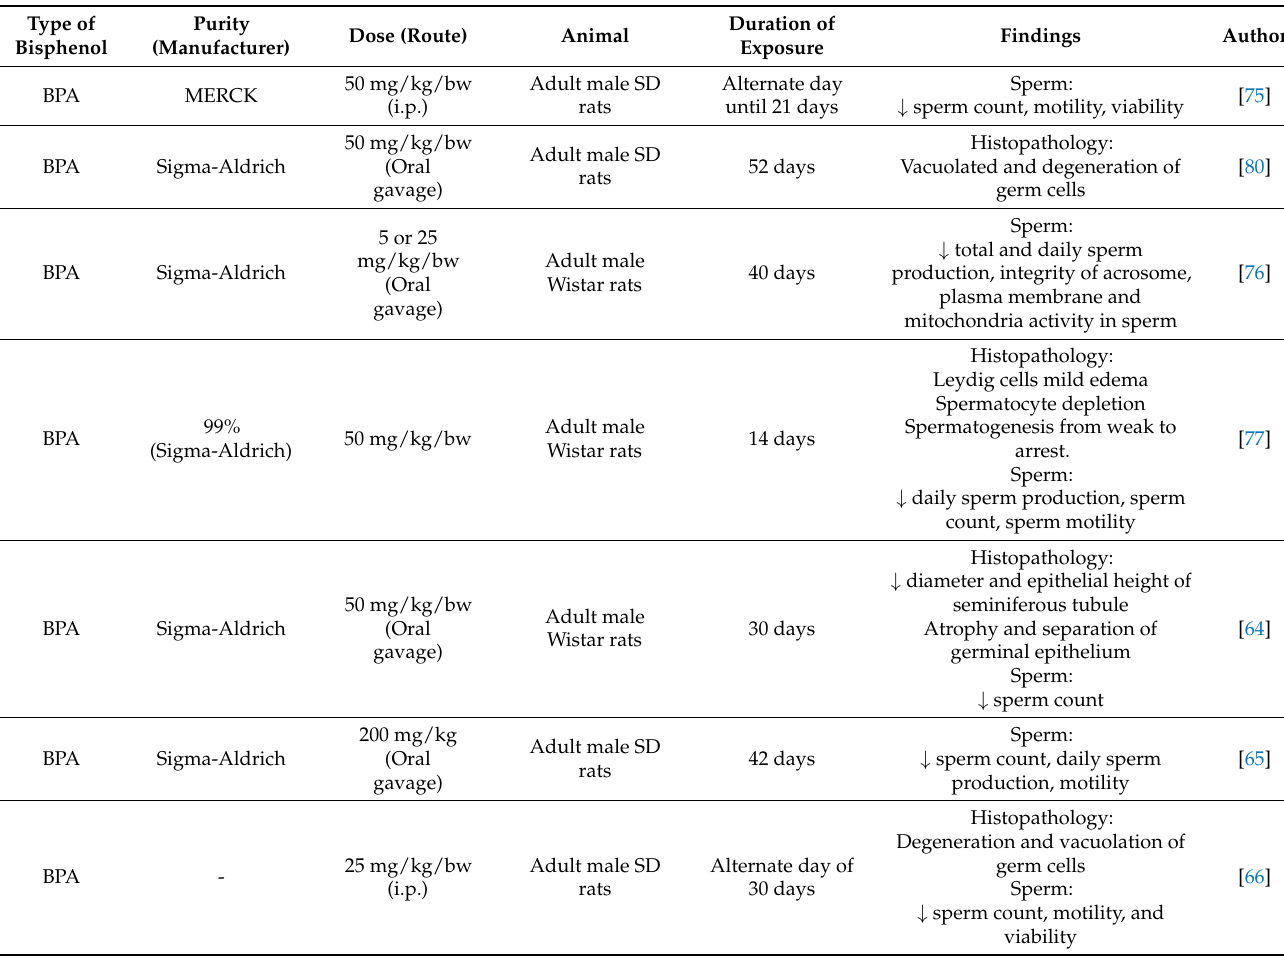
Table 3. The effects of BPA and its analogues on spermatogenesis in the male reproductive system. Type of